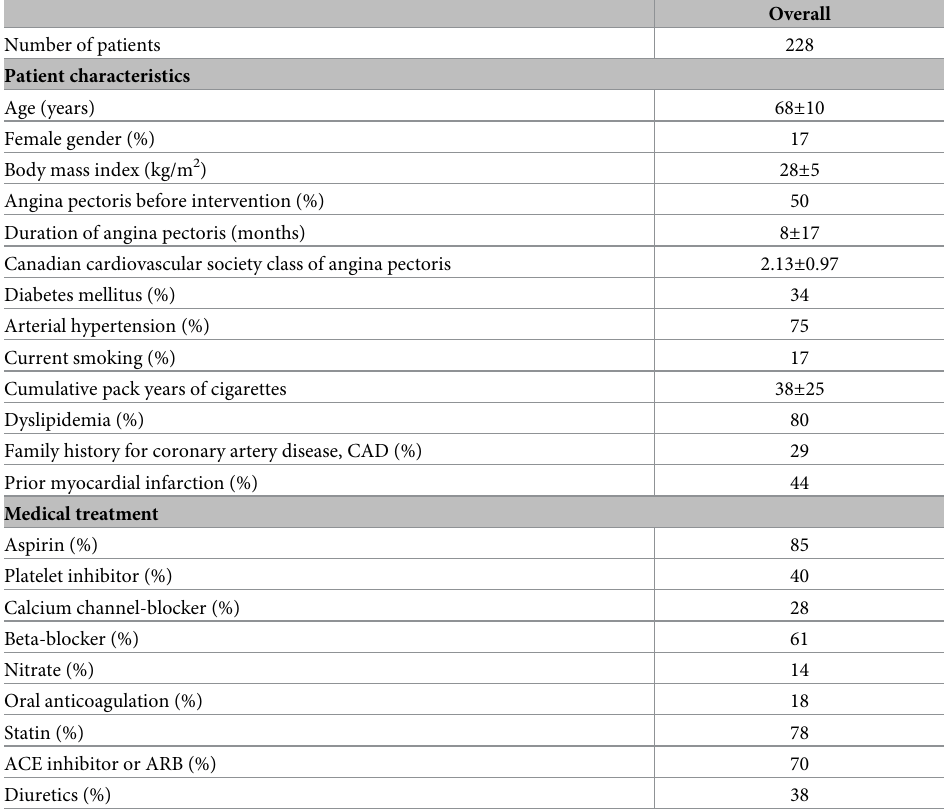
Table 1. Patient